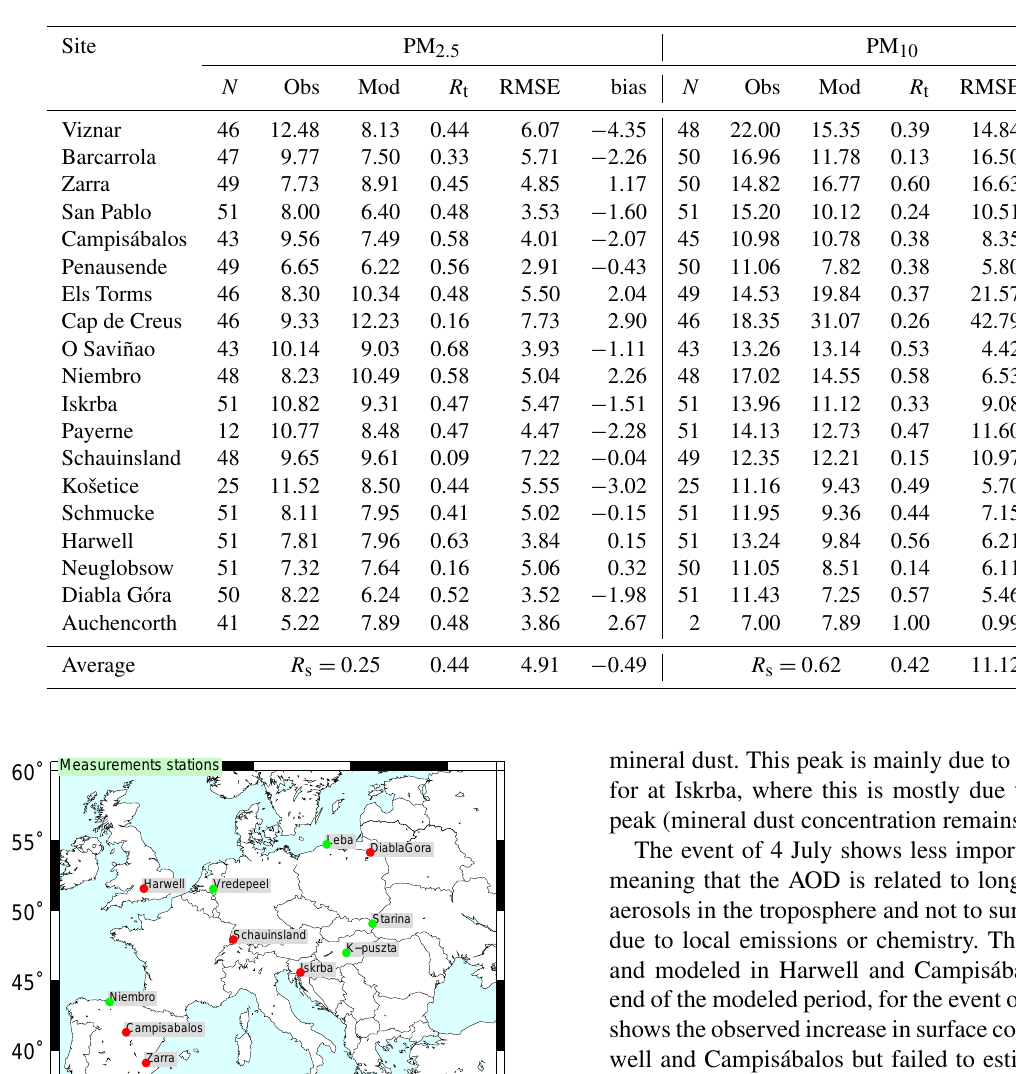
Table 7. Scores for the comparisons between observations (EMEP) and model (CHIMERE) for PM 2 . 5 and PM 10 . Results are presented with N the number of daily mean available measurements for the period from 10 June to 30 July 2013, the temporal correlation ( R t ), the root mean square error (RMSE) and the bias (model minus observations). The last line “average” represents the spatial correlation R s between the mean observed and modeled values, and the mean averaged values of temporal correlation, RMSE and bias. Stations are sorted in increasing latitude, from south to north.